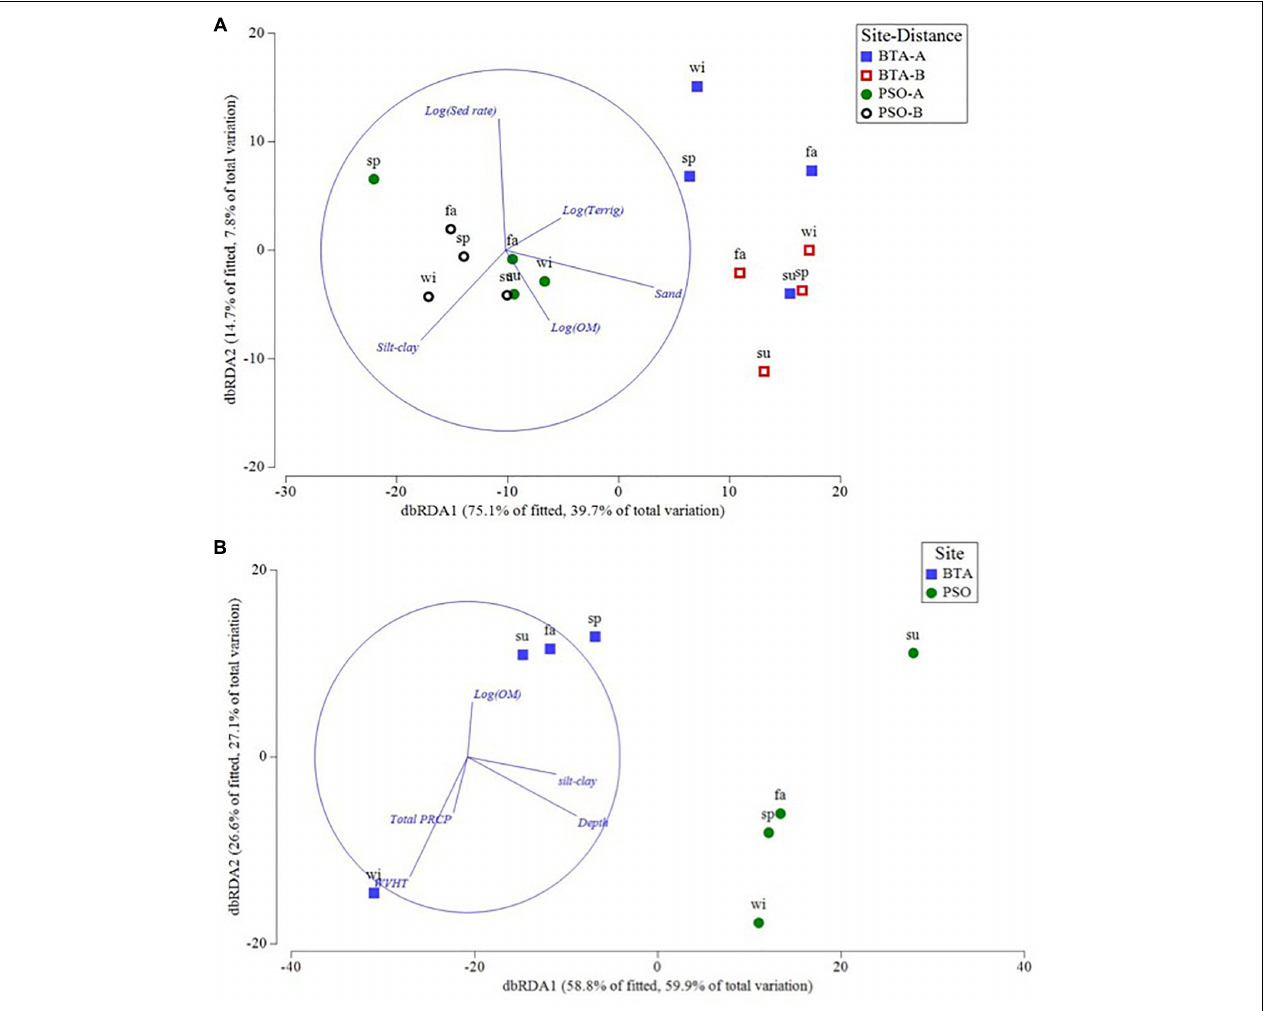
FIGURE 11 | Plot of redundancy analysis (dbRDA) for coral colony abundance (A) and coral recruit abundance (B) . Vectors represent environmental variables that best explains variation in coral abundance structure (A) between site by distance zone, and in coral recruit abundance (B) between sites. Blue and red squares represent Bahía Tamarindo (BTA); green and black represent Punta Soldado (PSO). Seasons are defined as: sp, spring; su, summer; fa, fall; wi,